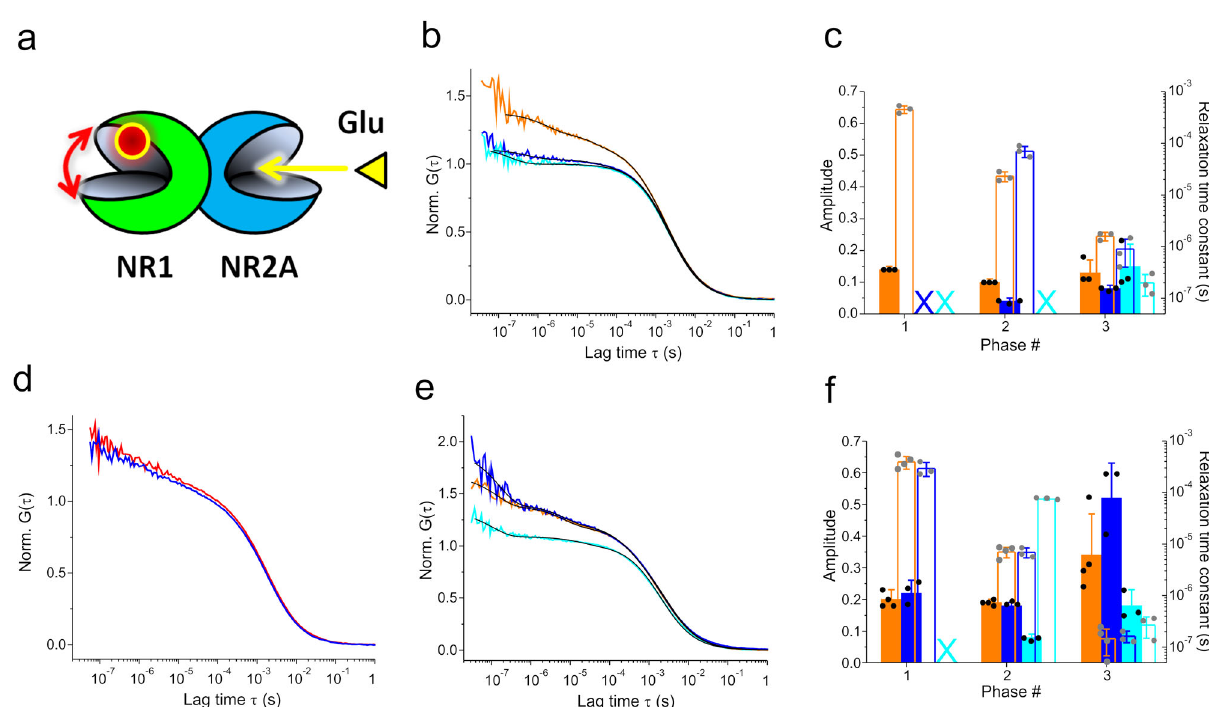
Fig. 5 Allosteric communication of clamshell dynamics in NMDA iGluR LBD dimers. a Design of the reporter system that senses effects of agonist binding to the GluN2A LBD on dynamics of the GluN1 LBD. The fl uorescence label on the GluN1 LBD is illustrated by a red sphere and LBD clamshell dynamics by a red arrow. Binding of agonist Glu is indicated by a yellow arrow. b ACFs, G( τ ), normalized to the average number of molecules in the detection focus, recorded from the GluN1 LBD within the GluN1/GluN2A dimer (orange data, GluN1-LBD-A480C-N521Y/GluN2A-LBD-E516Y). ACFs of the hetero-dimer measured in presence of the agonist Glu or Gly are shown in blue and cyan, respectively. Black lines are fi ts to the data using a model for molecular diffusion containing a sum of one to three single-exponential decays (indicated in panel ( c )). c Amplitudes (closed bars) and corresponding time constants (open bars) of exponential decays of ACFs recorded from the GluN1/GluN2A dimer. Data sets and color code correspond to ACFs shown in panel ( b ). Crosses (X) denote missing (not detected) kinetics. d ACFs of the monomeric apo GluN1-LBD (construct A480C-N521Y) measured in absence (red) and in presence (blue) of 1 mM Glu. e ACF of the GluN1/GluN2A LBD dimer containing mutation Y535S (construct GluN1-LBD-A480C-N521Y- Y535S/GluN2A-LBD-E516Y), measured in the apo state (orange), in the presence of Glu (blue), or in the presence of Gly (cyan). Black lines are fi ts to the data using a model for molecular diffusion containing a sum of two or three single-exponential decays (indicated in panel ( f )). f Amplitudes (closed bars) and corresponding time constants (open bars) of exponential decays of ACFs recorded from the GluN1/GluN2A LBD dimer containing mutation Y535S. Data sets and color code correspond to the ACFs shown in panel ( e ). The cross (X) denotes missing (not detected) kinetics. Error bars are s.d. of three measurements ( n = 3).